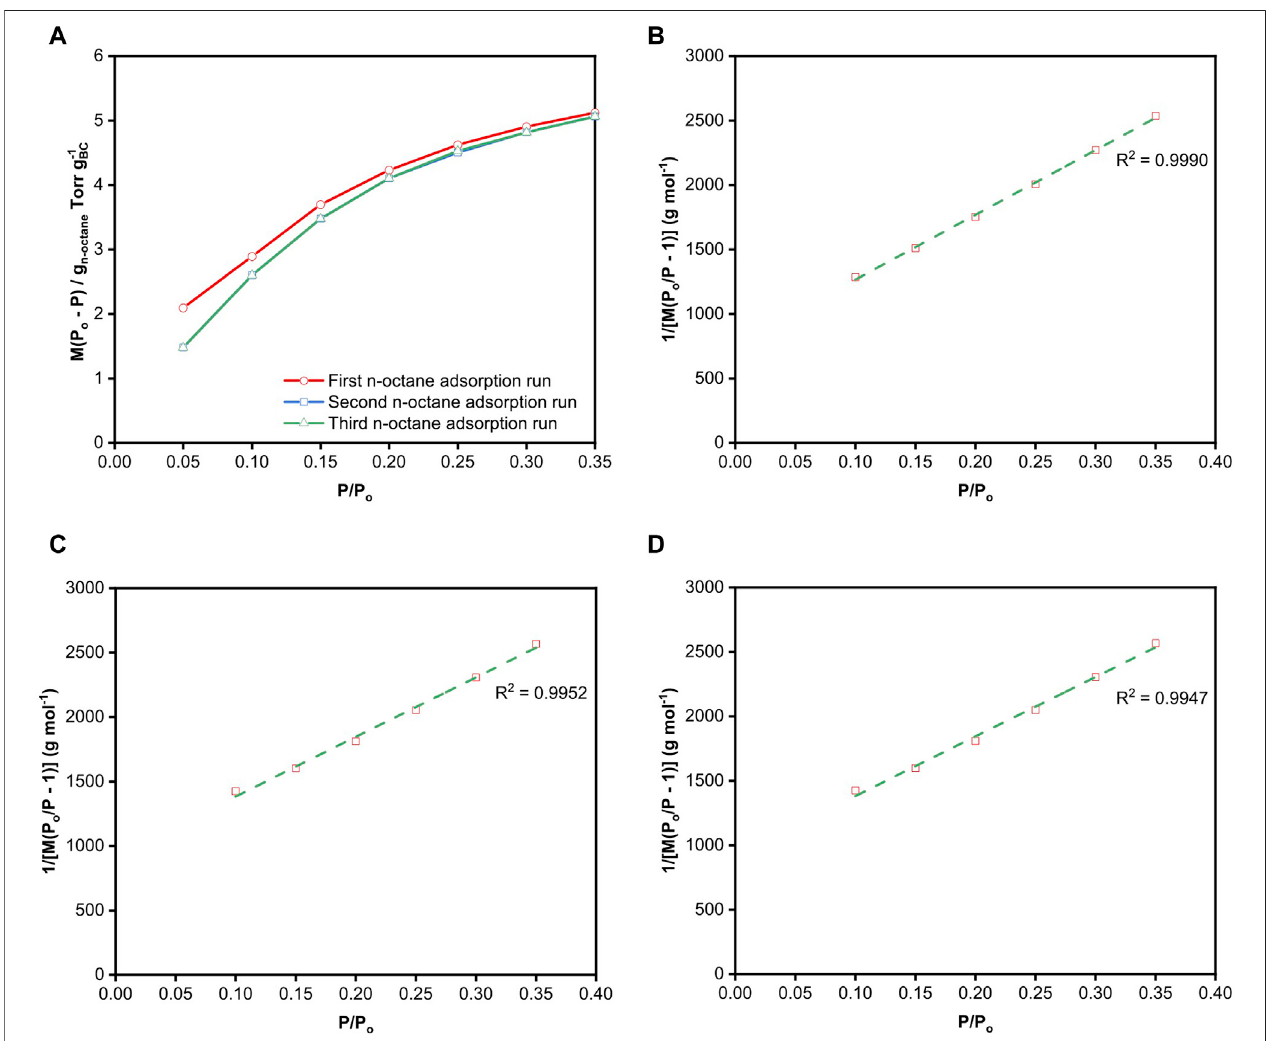
FIGURE 4 | (A) M ( P o − P ) vs P / P o plot of n-octane adsorption on freeze-dried BC determined using DVS, which shows that the range 0.05 ≤ P / P o ≤ 0.35 can be usedforBETanalysis.Notethatthecurvesforthesecondandthirdadsorptionrunsoverlappedontopofeachother.BETplotsoffreeze-driedBCobtainedfromthe (B) fi rst, (C) second and (D) third n-octane adsorption runs, fi tted over the range of 0.10 ≤ P / P